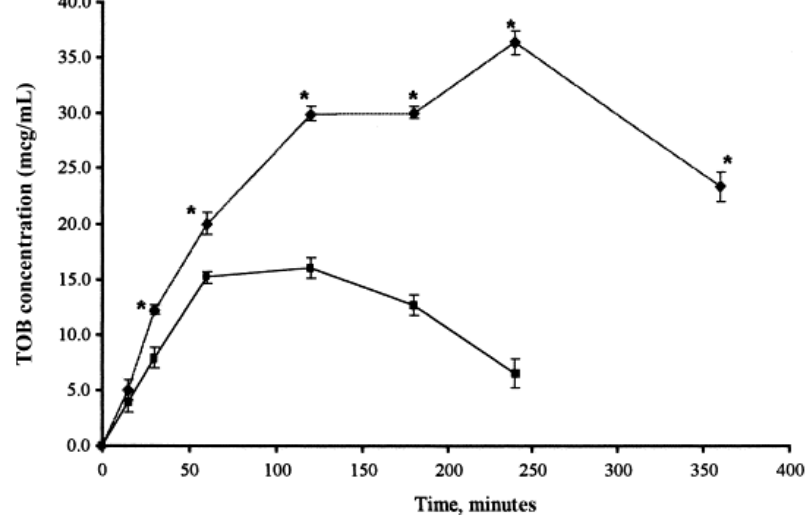
Figure 8. Concentration-time profile of Tobramycin (TOB) in the aqueous humor of rabbit after the instillation of the reference solution ( ■ ) and TOB-SLN ( ♦ ). Reprinted from [147]. Copyright (2018), with permission from